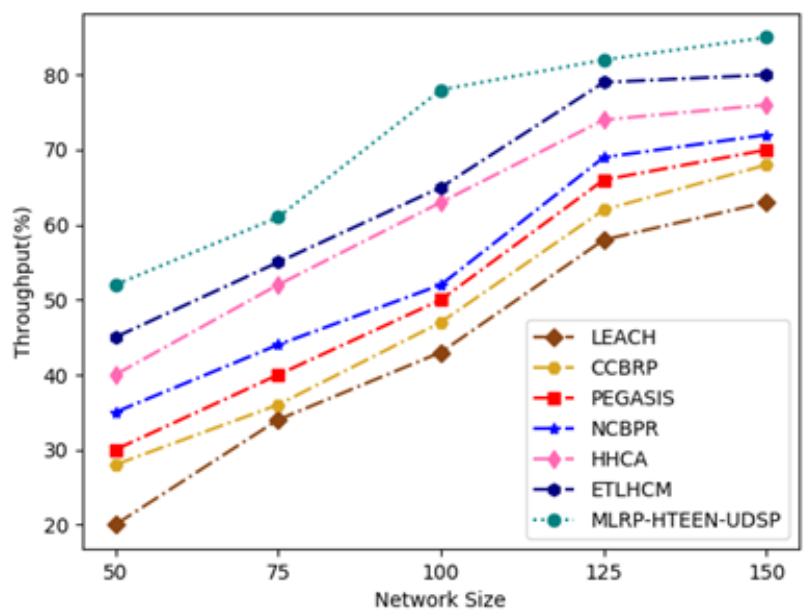
Figure 6. Comparison of throughput.